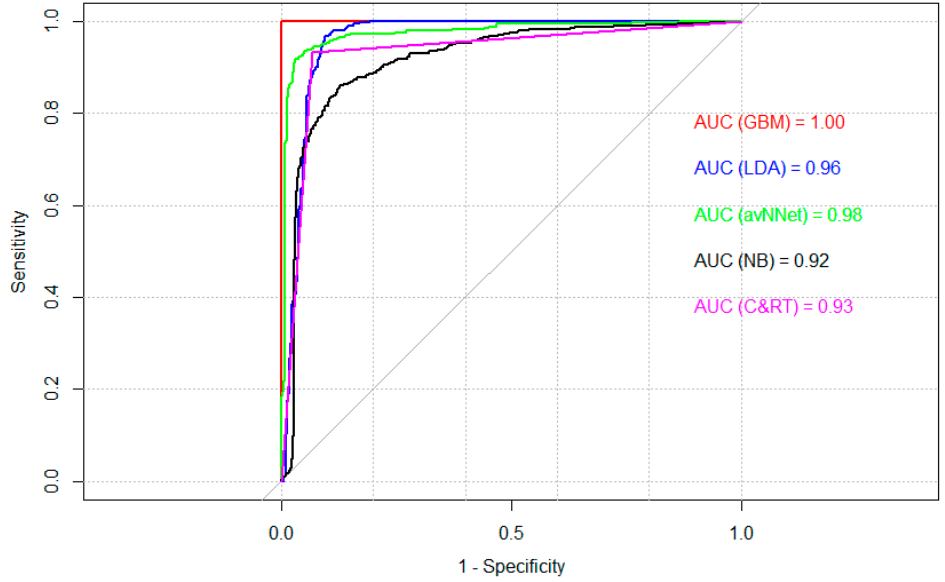
Figure 10. ROC curves for models LDA, NB, C&RT, avNNet and GBM for the training sample. Source: own elaboration using the R package.